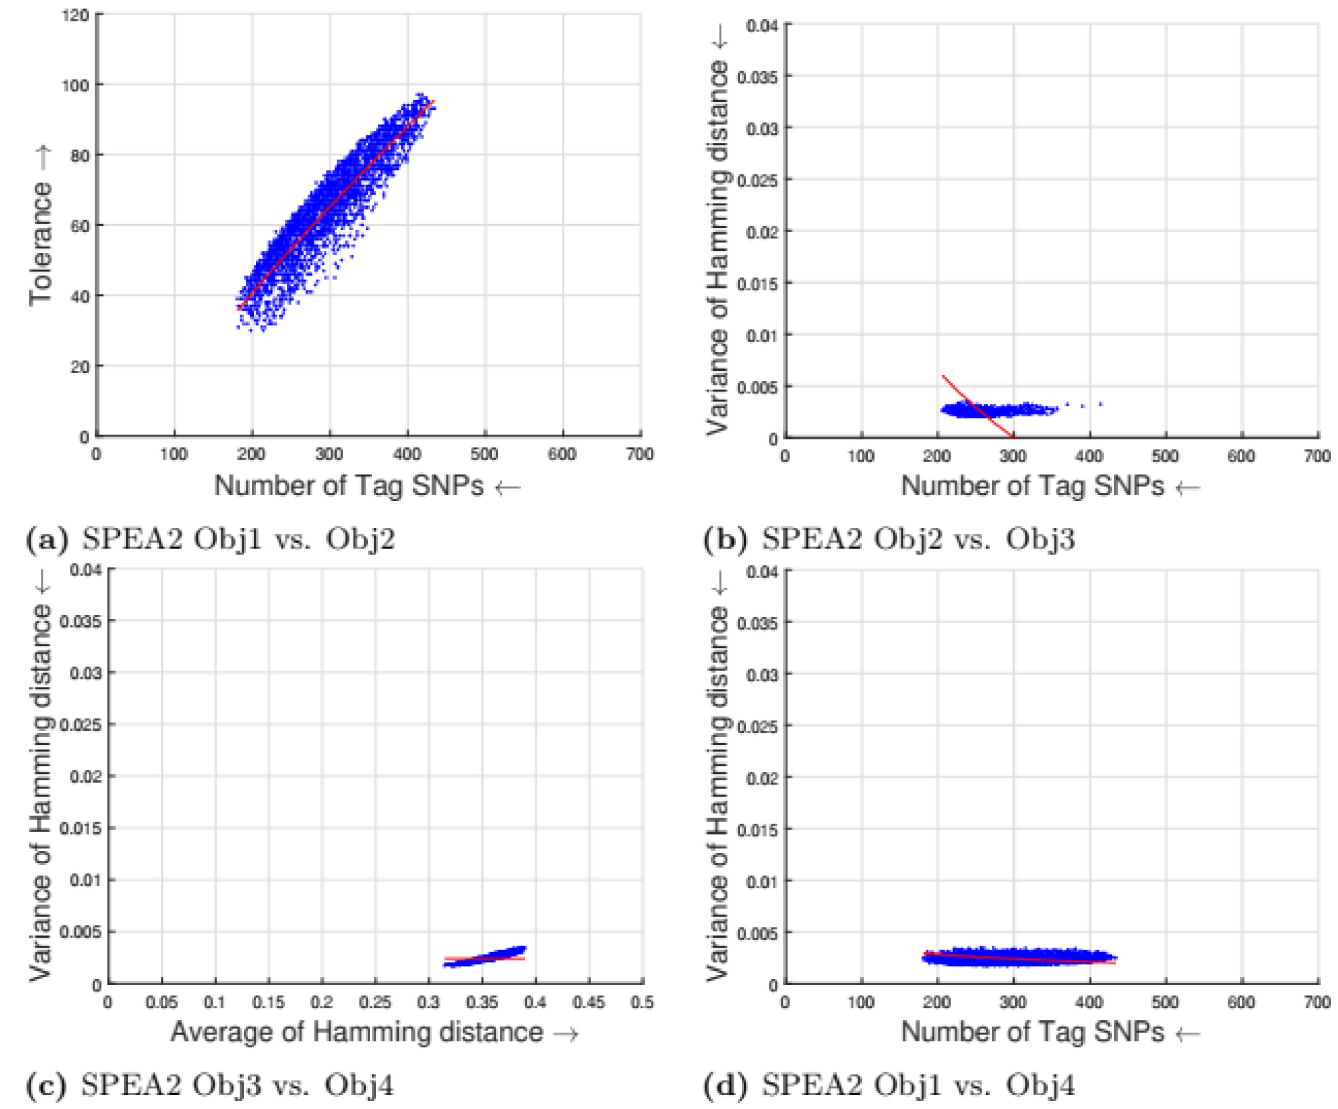
Fig 6. Experimental results of SPEA2 using greedy initialization for the tag SNPs selection problem. Obj1 stands for the number of tag SNPs, Obj2 is the tolerance for missing data, Obj3 measures the average Hamming distance between alleles, and Obj4 controls the variance of detection power in each allele. (a) SPEA2 Obj1 vs. obj2, (b) SPEA2 Obj2 vs. obj3, (c) SPEA2 Obj3 vs. obj4, (d) SPEA2 Obj1 vs. obj4.